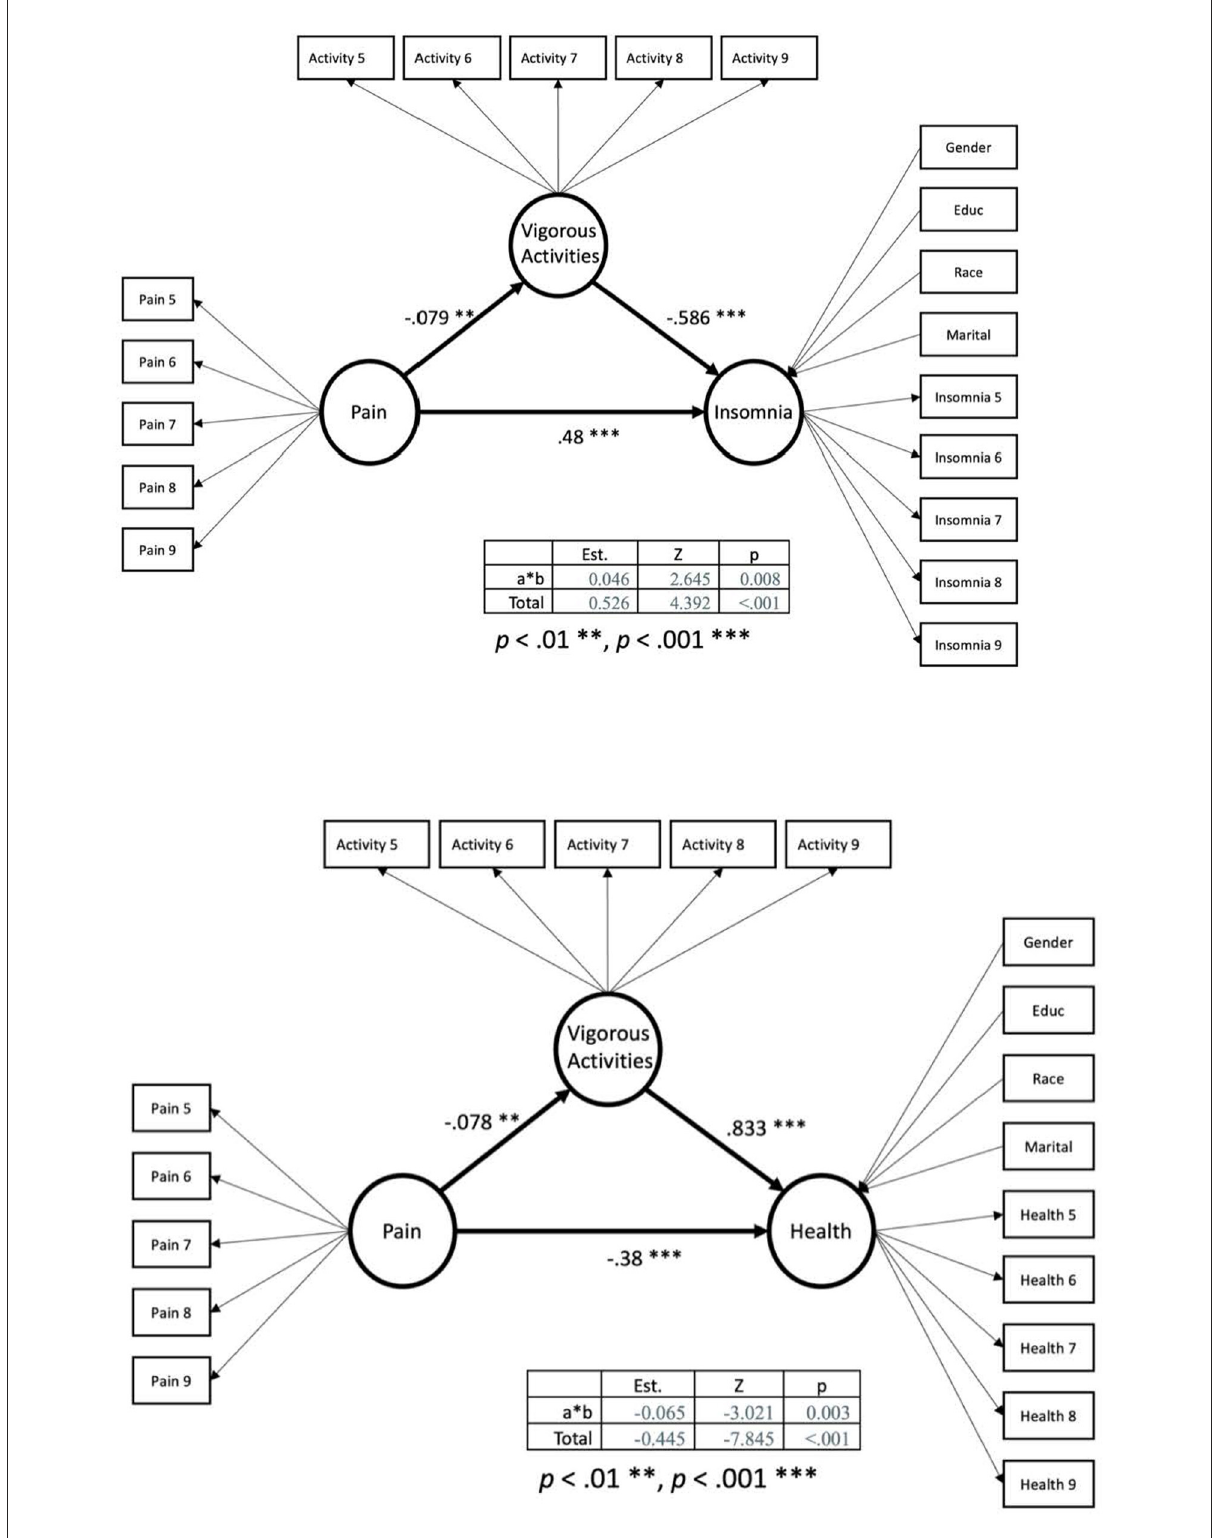
FIGURE2 Mediation model with vigorous activities mediating relationship between pain and